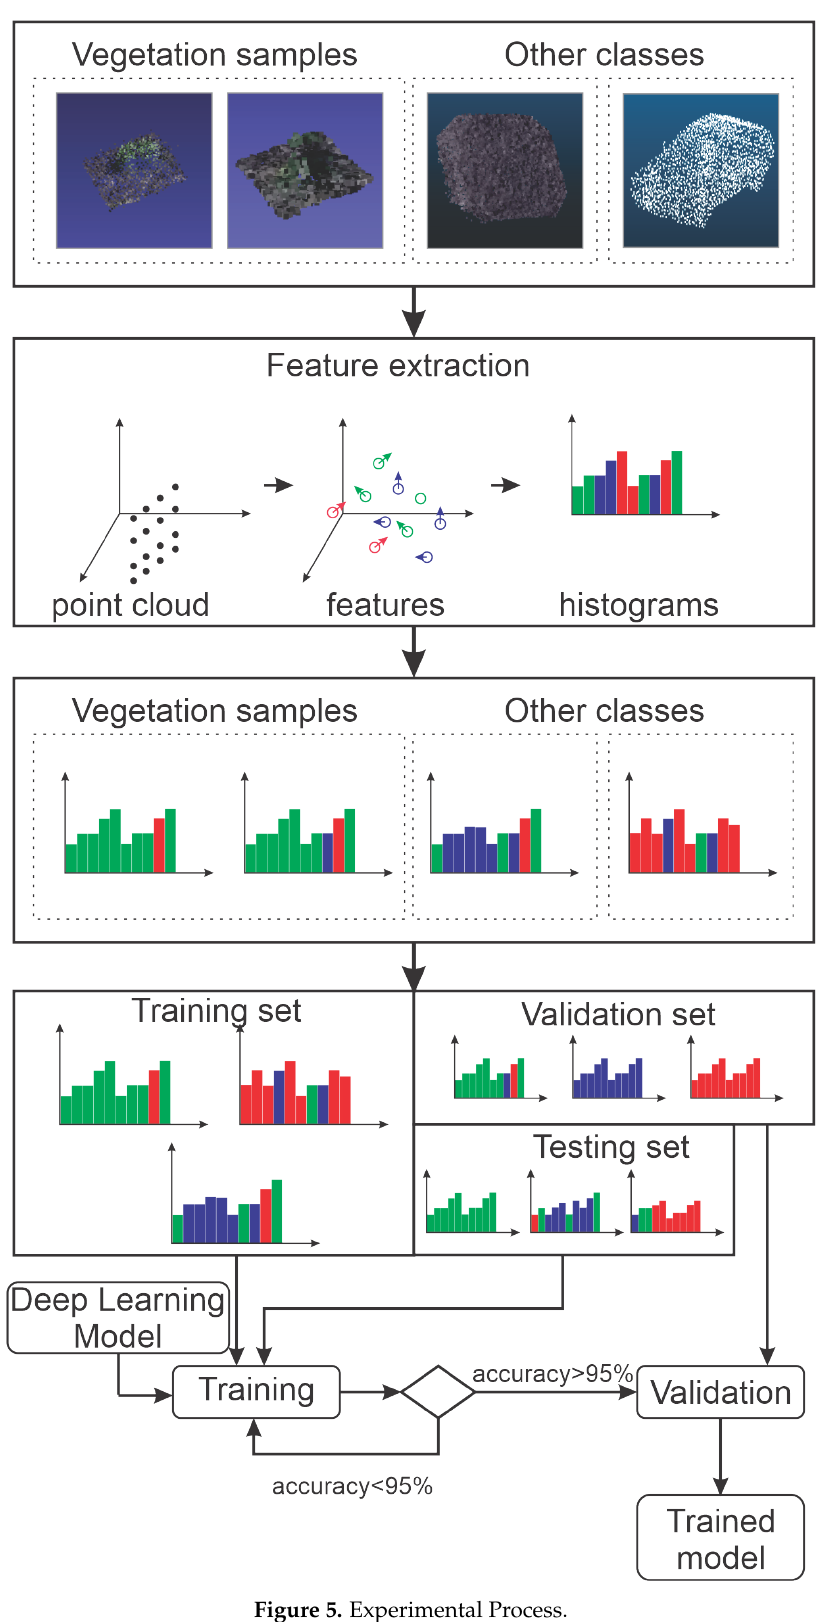
Figure 5. Experimental